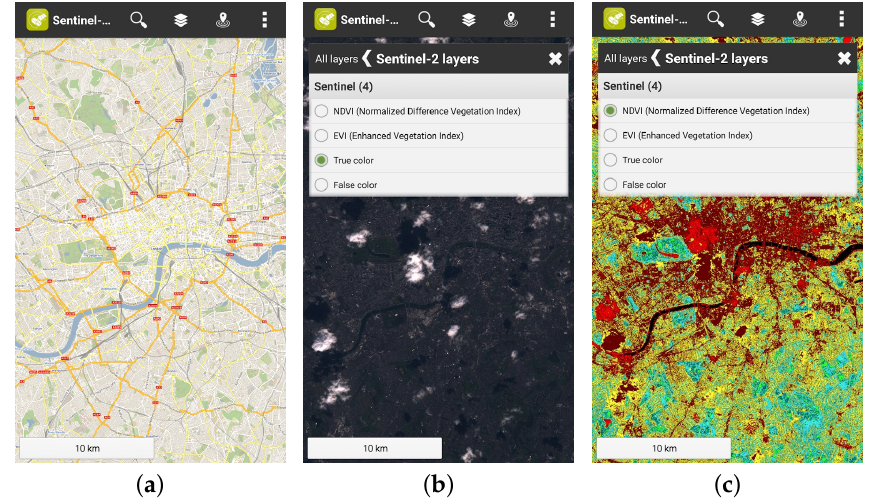
Figure 25. Sentinel-2 NDVI Maps: ( a ) Visualizing the Open Street Map layer; ( b ) Visualizing the true color map layer; ( c ) Visualizing the NDVI map